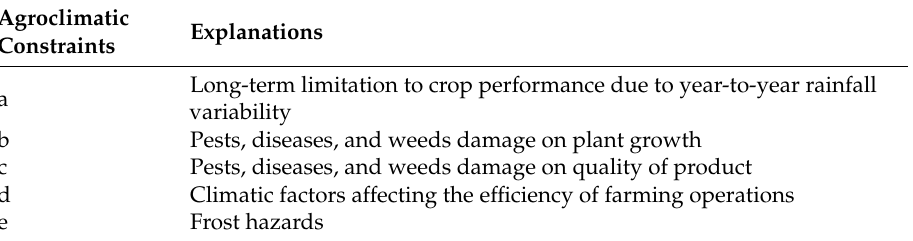
Table 3. Five agroclimatic